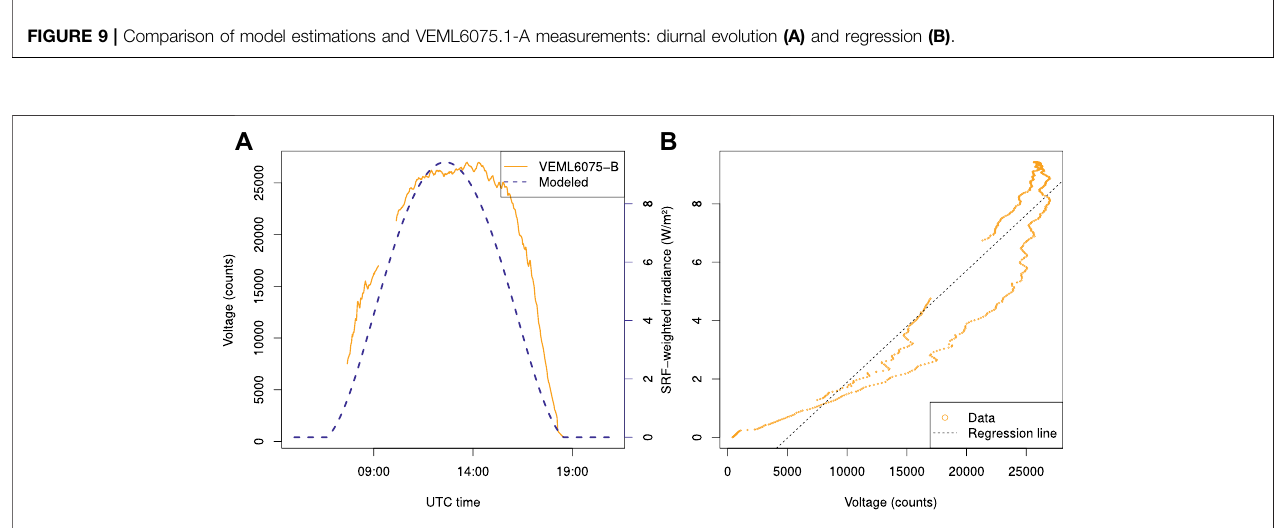
FIGURE 10 | Comparison of model estimations and VEML6075.2-B measurements: diurnal evolution (A) and regression (B) .